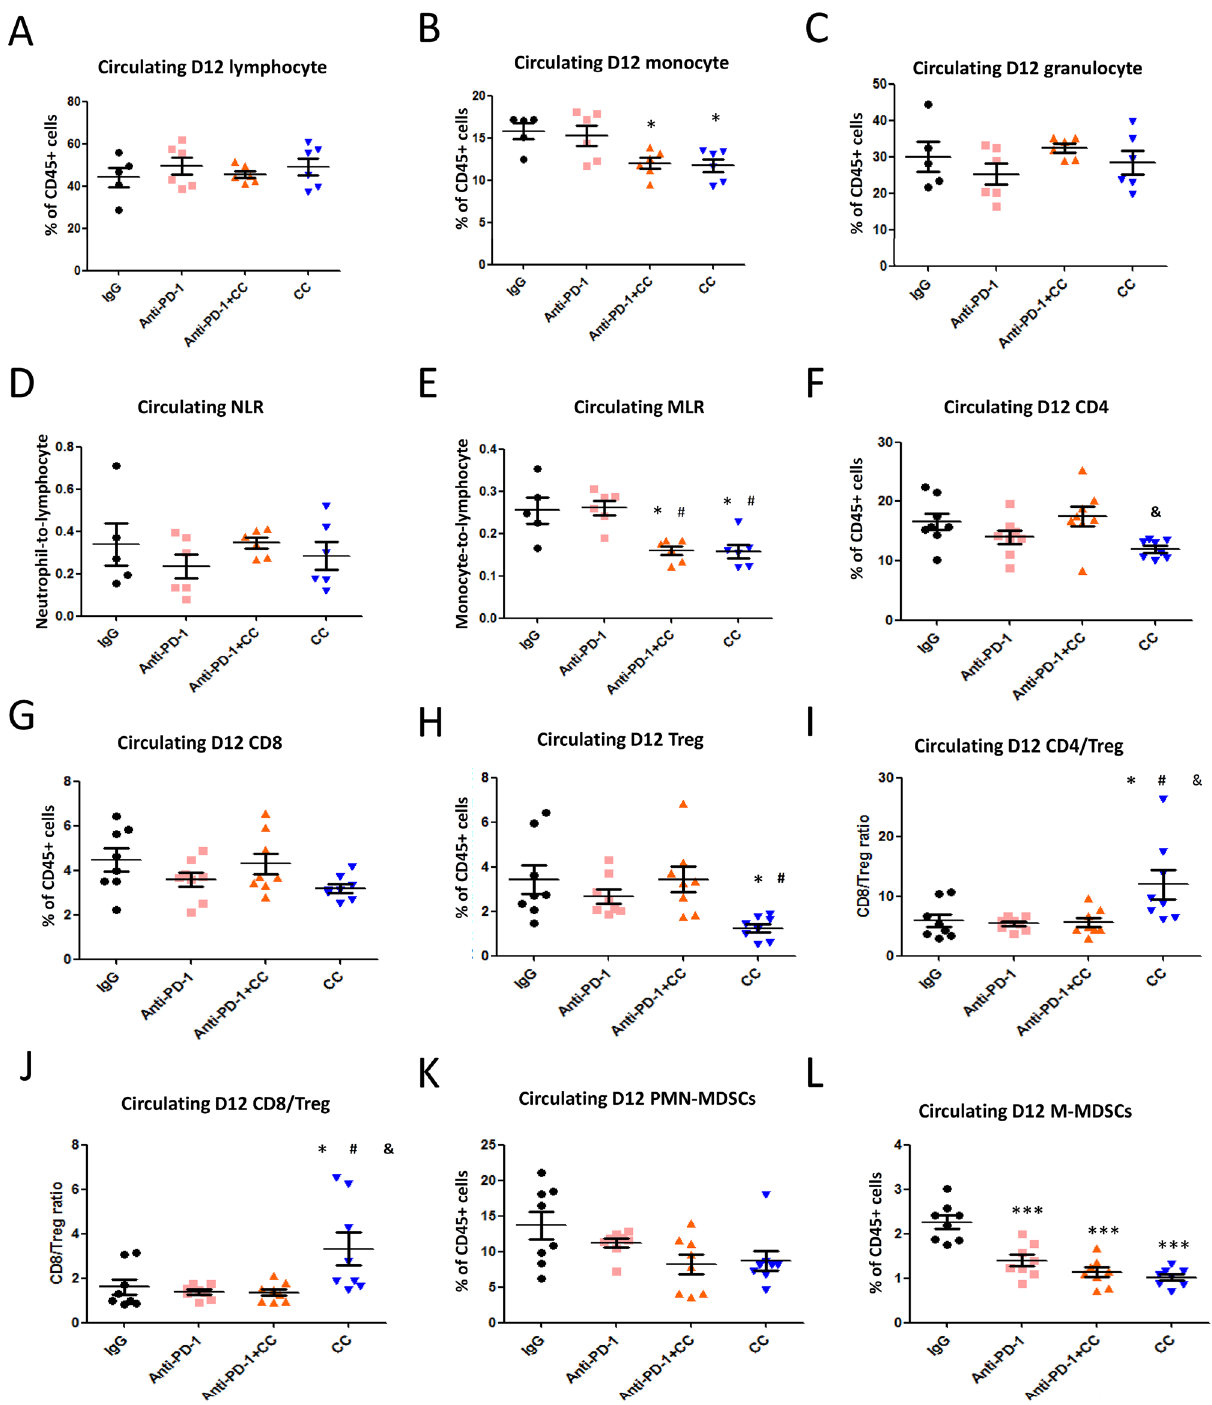
Figure 5. Populations of immune cells, including lymphocytes, Tregs and myeloid-derived MDSCs, in the blood circulation of CT26-bearing mice. CT26 tumor-bearing mice were orally administered a chidamide-k30 solution and celecoxib (50 mg/ kg) once daily from days 10 to 22 (Day 10 mean tumor volume (TV), 220–240 mm 3 ). The mice were treated with anti-PD-1 antibody (2.5 mg/kg, i.p.) once every 3 days on days 10, 13, 16, 19, and 22. Blood samples were obtained on day 12 after treatment for analysis of circulating cell populations. ( A–C ) Flow cytometric analysis of lymphocytes, monocytes, and granulocytes in peripheral blood. Results are shown as mean ± standard deviation (SD). *p < 0.05 or **p < 0.01 vs. anti-IgG. ( D,E ) Ratios of neutrophil-to-lymphocyte and monocyte-to-lymphocyte in peripheral blood by Flow cytometric analysis. Results are shown as mean ± SD. *p < 0.05 vs. anti-IgG; # p < 0.05 vs. anti-PD-1. ( F–H ) Flow cytometric analysis of CD4 + , CD8 + , and Treg cell populations in peripheral blood. Results are shown as mean ± SD. & p < 0.05 vs. anti-PD-1 + CD + C. ( I,J ) CD4 + / Treg and CD8 + /Treg ratios in peripheral blood by Flow cytometric analysis. Results are shown as mean ± SD. *p < 0.05 vs. anti- IgG, # p < 0.05 vs. anti-PD-1, & p < 0.05 vs. anti-PD-1 + CD + C. ( K,L ) Flow cytometric analysis of myeloid-derived PMN-MDSC and M-MDSC cell populations in peripheral blood. Results are shown as mean ± SD. ***p < 0.001 vs. anti-IgG (n =